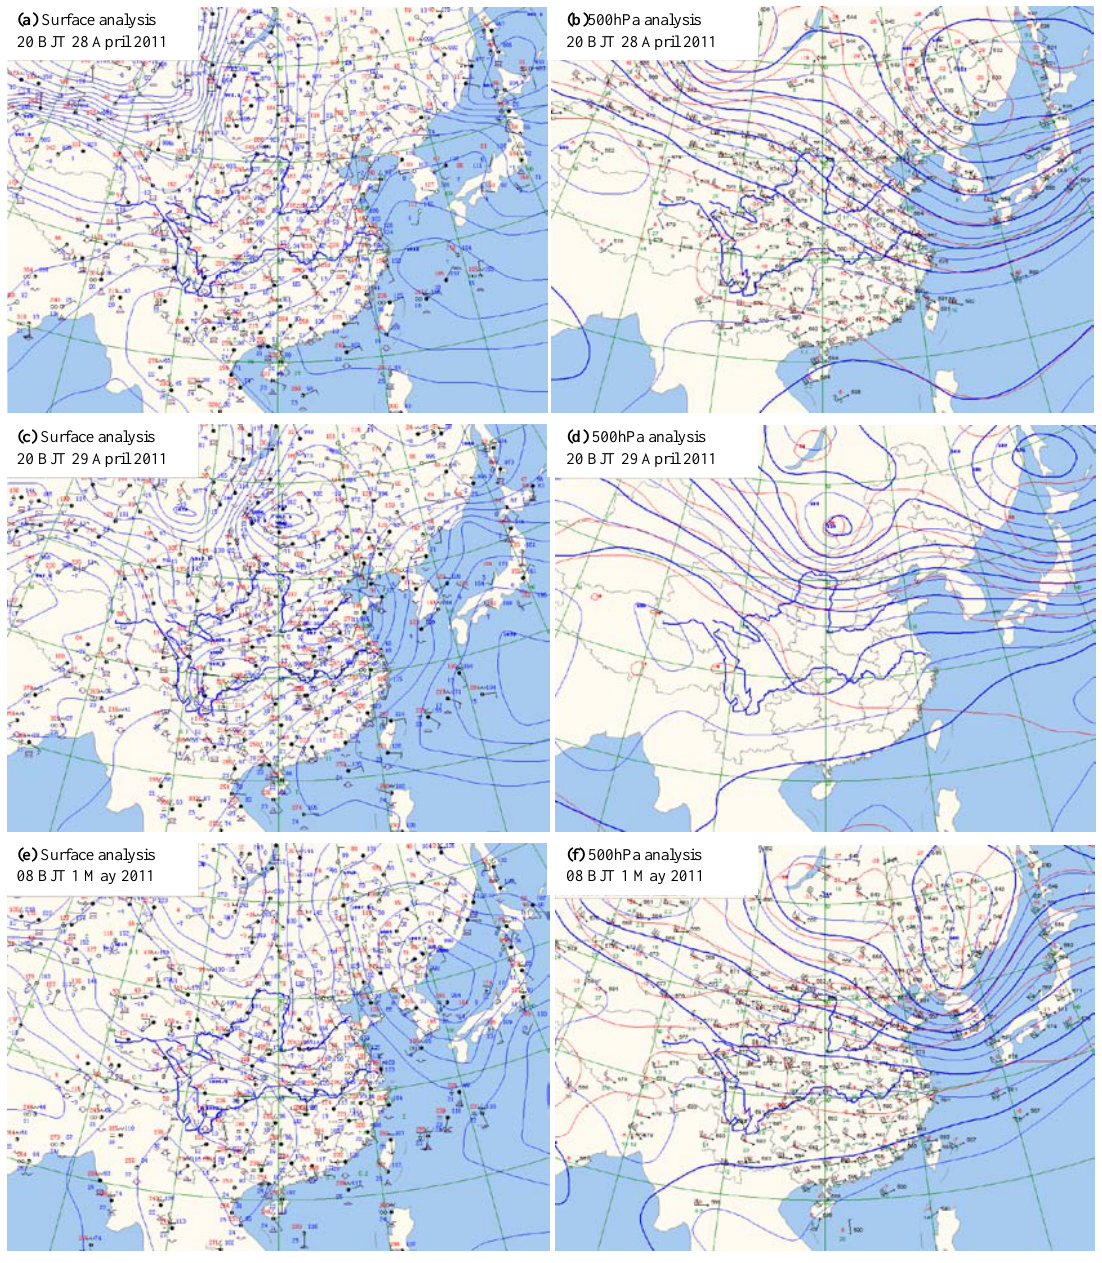
Fig. 6. Surface and 500hPa weather chart in China for 28 April (a, b) , 29 April (c, d) and 1 May 2011 (e, f) . Fig.6. Surface and 500 hPa weather chart in China 4.4 Deposition of dust aerosols in the YRD (http://218.94.36.199:5050/dmsg/map.htm)